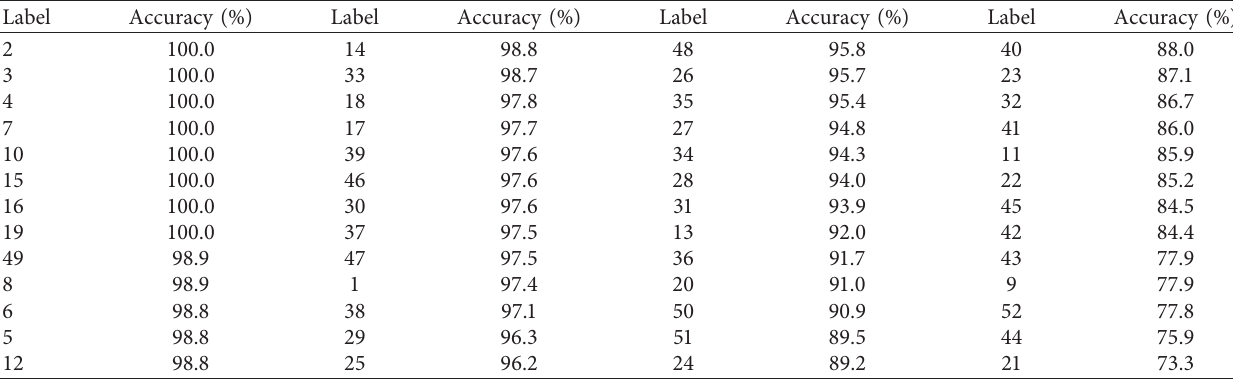
Table 3: The accuracy for 52 movements.